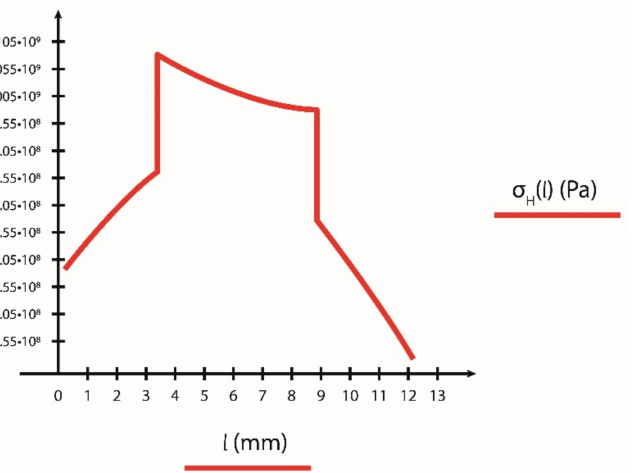
Figure 4. The change in Hertzian stress along the path of contact is shown using the data of the sample